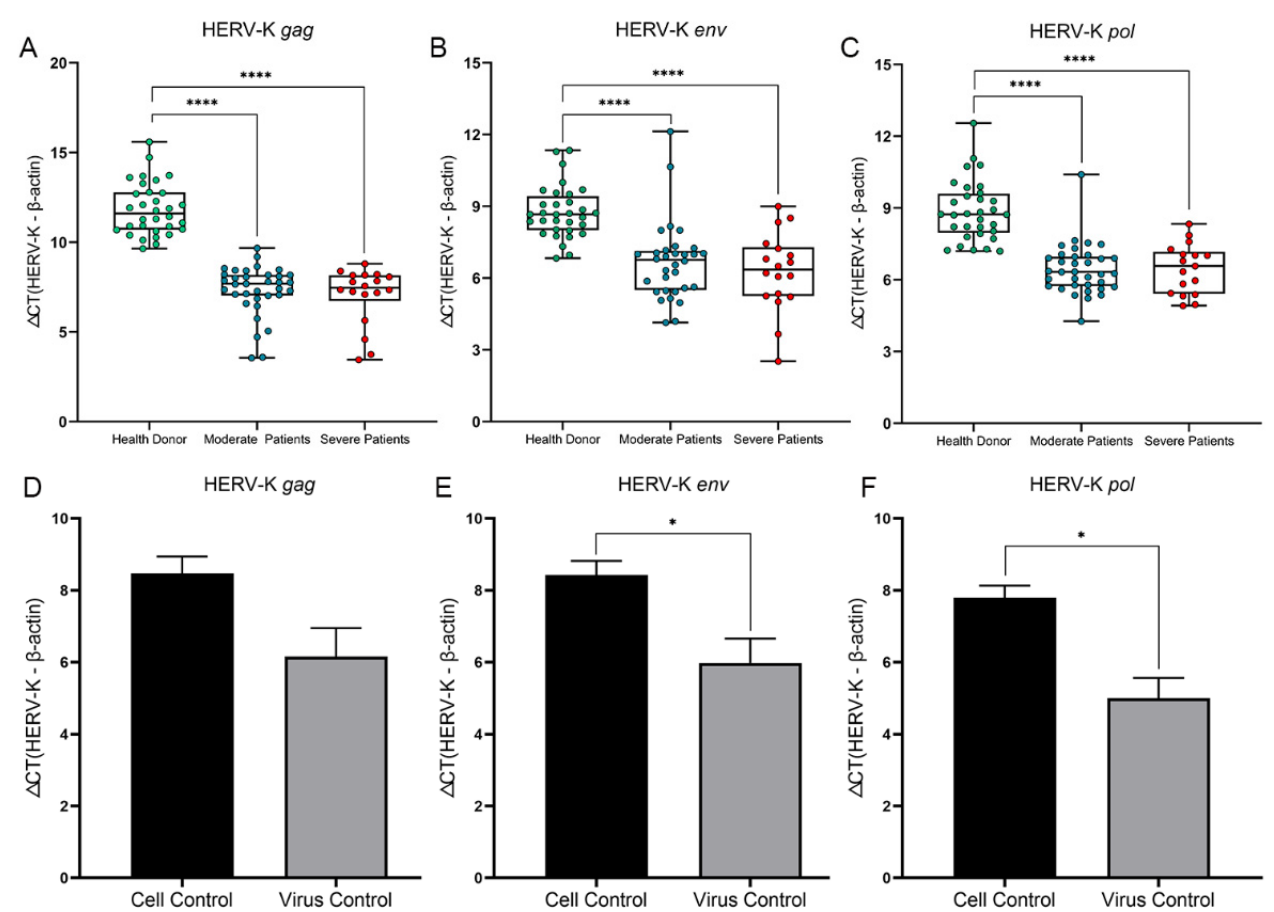
Figure 1. Comparison of the HERV-K (HML-2) gag , env , and pol genes in COVID-19 patients and VERO cells infected with SARS-CoV-2. ( A – C ) The expression of HERV-K (HML-2) gag , env , and pol genes in health donor (green dot), moderate (blue dot) and severe COVID-19 patients (red dot). ( D – F ) The expression of HERV-K (HML-2) gag , env , and pol genes in VERO cells control (black column) and VERO cell infected with SARS-CoV-2 (grey column). Each point represents three repeats. The box plots show the medians (middle line) and first and third quartiles (boxes), and the whiskers show the minimum and maximum. Mann–Whitney test p values are depicted in the plots. Mann-Whitney test P-values are depicted in the plots. * p < 0.05, **** p < 0.0001.